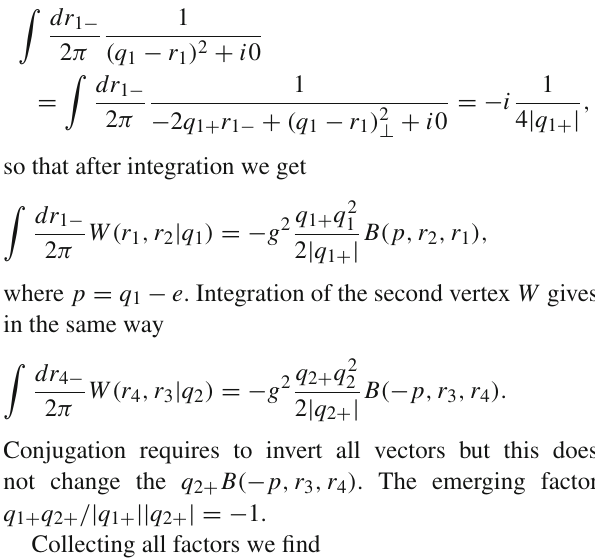
In the lowest order the blobs are usually taken as q ¯ q loops with the two reggeons attached to the quarks and antiquarks in all different ways. The reggeons are just gluons with the propagators depending on only their transverse